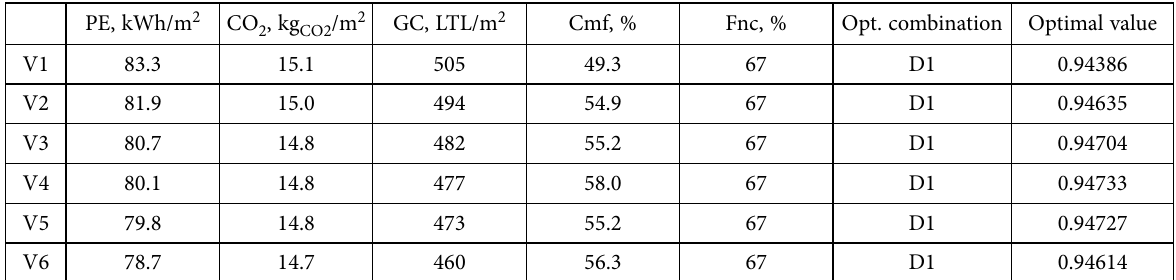
Table 5. The optimal values of variants of building